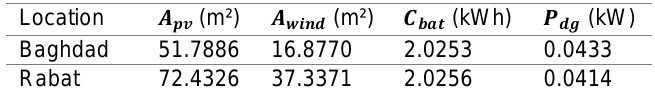
Table 8 . Design results